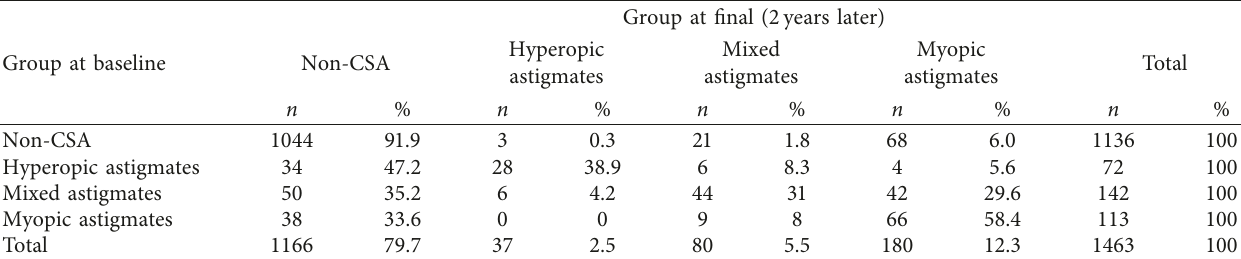
Figure 2: Absolute value of dioptric changes in cylinder refraction changes in the non-CSA and CSA groups. No-change subgroup, no change in diopters; increase subgroup, increases in diopters; decrease subgroup, decreases in diopters. Change 1: dioptric change � 0D; Change 2: dioptric change > 0 to < 0.5D; Change 3: dioptric change ≥ 0.5D to < 1.0D; Change 4: dioptric change ≥ 1.0D. Table 2: Comparison of the type of astigmatism at initial examination and final examination in the 1463 children who underwent follow-up examination at